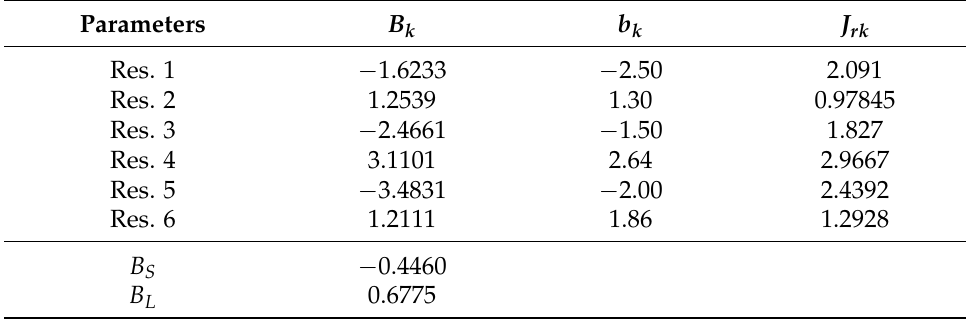
Table 3. Extracted elements of the 6th-order filter prototype with a Ω Dk TZs